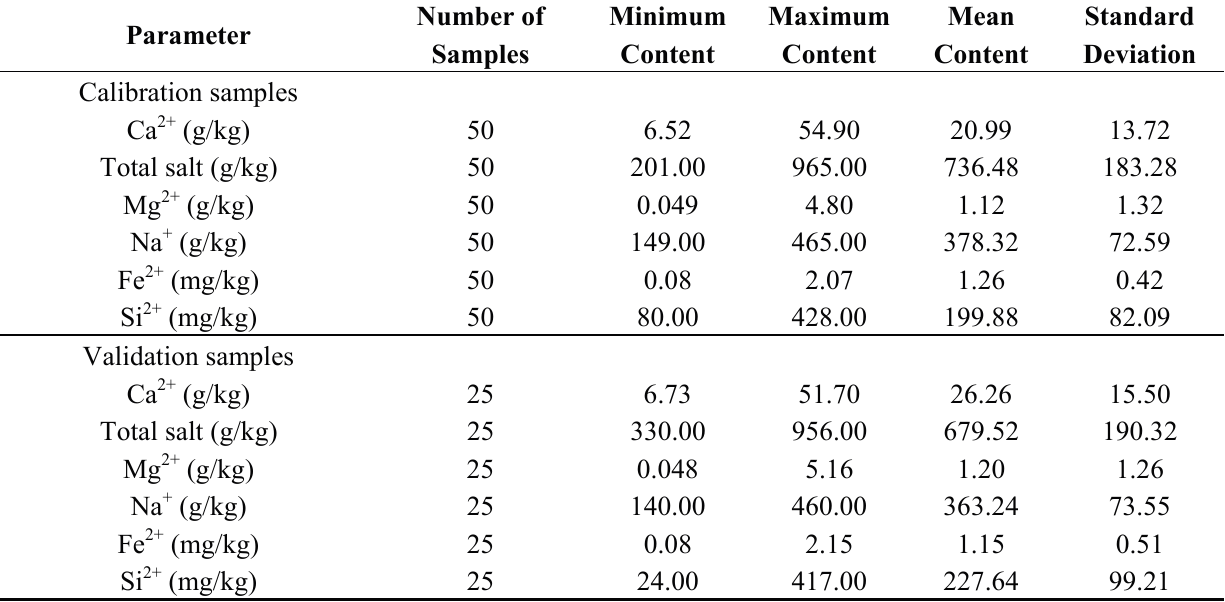
Table 1. Calibration and validation datasets: number of samples, chemical content ranges, means, and standard deviations for the salt-crust properties